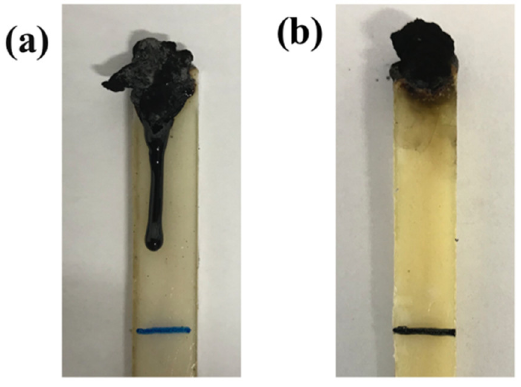
Figure 4. The digital images after the LOI test: ( a ) MXD6 and ( b ) MXD6/DT/P22.